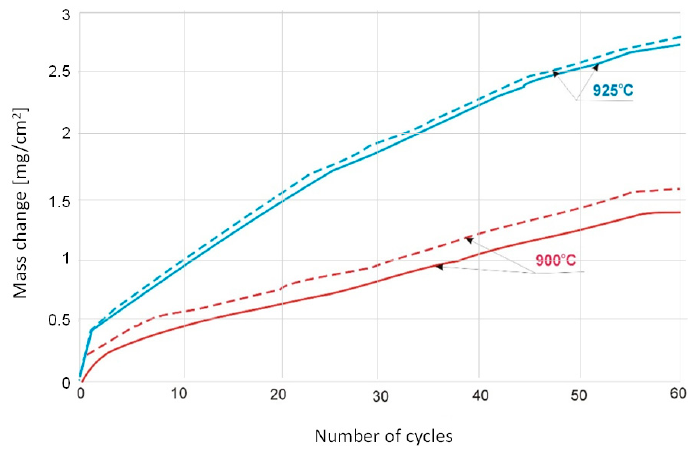
Figure 4. Mass change of Ti-46Al-7Nb-0.7Cr-0.1Si-0.2Ni per unit area with respect to exposed temperature (continuous curves—cooling in still air, dot curves—cooling in compressed air).